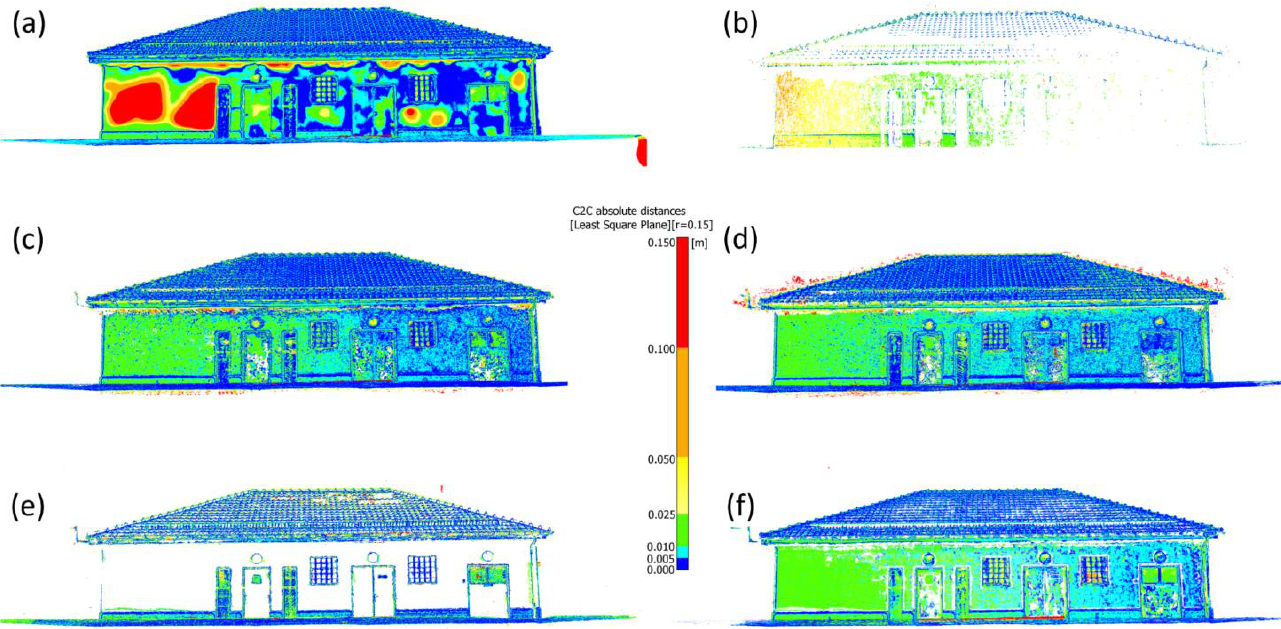
Figure A3. Comparison of TLS and image-based point clouds of elevation 1: ( a ) ContextCapture; ( b ) GRAPHOS; ( c ) Metashape; ( d ) PhotoScan; ( e ) Pix4DMapper; ( f ) RealityCapture.